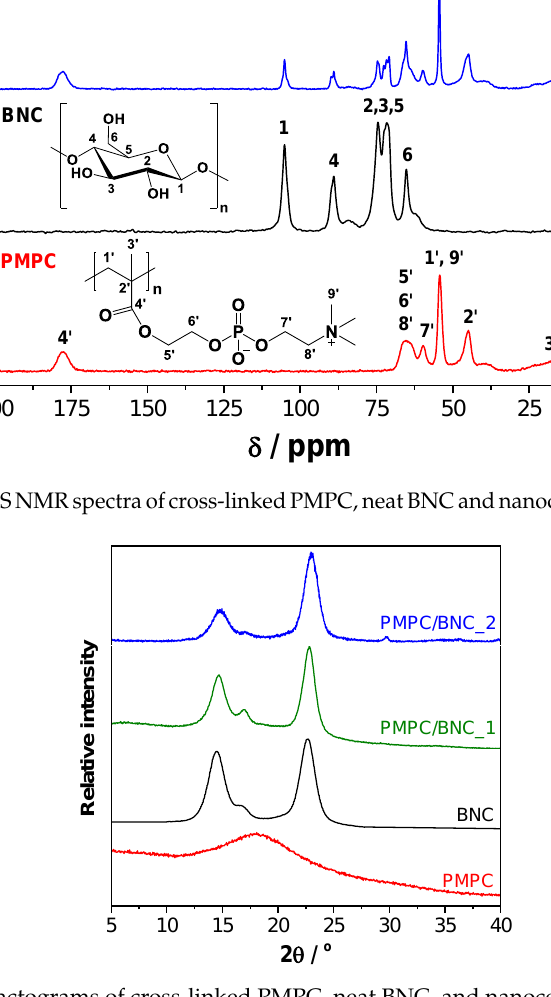
Figure 3. 13 C CP/MAS NMR spectra of cross-linked PMPC, neat BNC and nanocomposite PMPC/BNC_2.